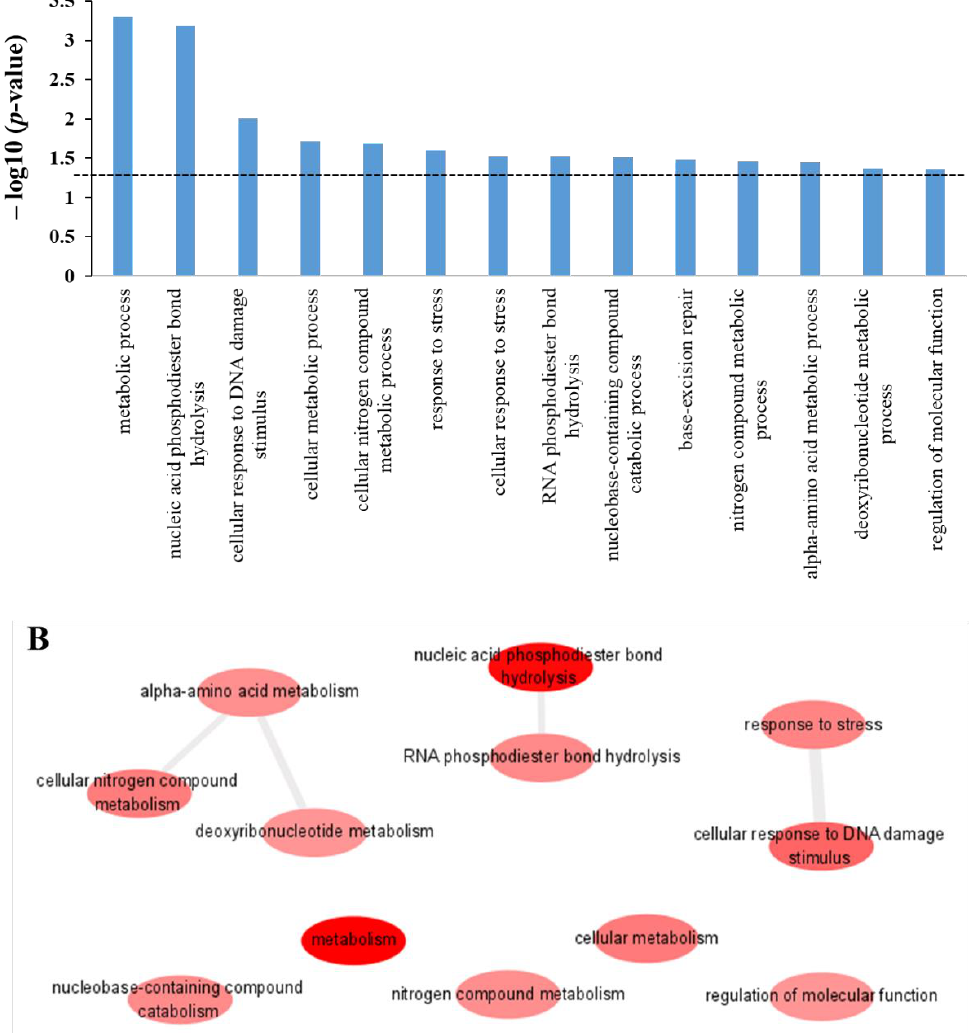
Figure 4. Enrichment in biological process category of gene ontology (GO) for the protein targets of polyphemusin-I. ( A ) GO biological process enriched terms analyzed by DAVID database and the use of p -value cutoff ≤ 0.05 to select significant enrichment (dotted line represent p -value = 0.05). ( B ) REVIGO analysis for the selection of non-redundant GO term from the list of DAVID generated GO enrichment results in biological process. Bubble indicated enriched non-redundant GO term and the color (red to pink) represent significant enrichment based on the p -value. The highly similar non-redundant GO terms showed the connection and the width of line represent the degree’s